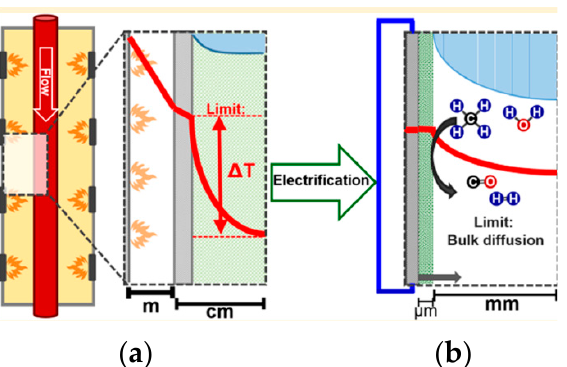
Figure 3. Electrified compact reactor with temperature profile on catalyst surface with thermal heating ( a ) and electrical heating ( b ). Reprinted from [104].